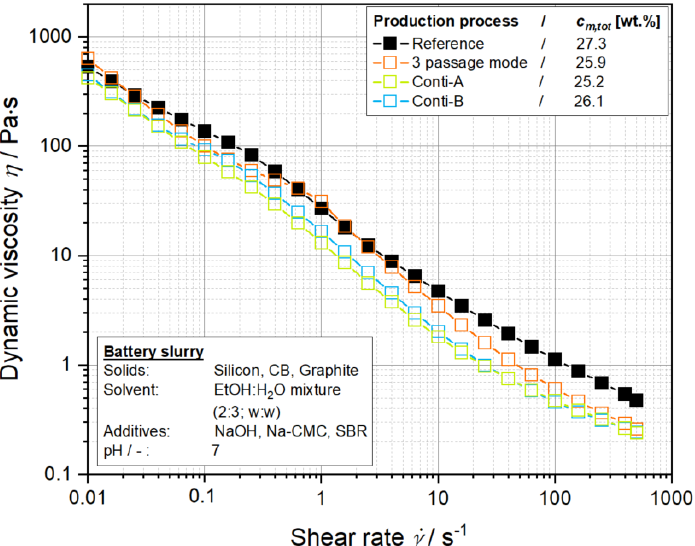
Figure 15. Dynamic viscosity of battery slurries produced by four different processes as a function of shear rate.